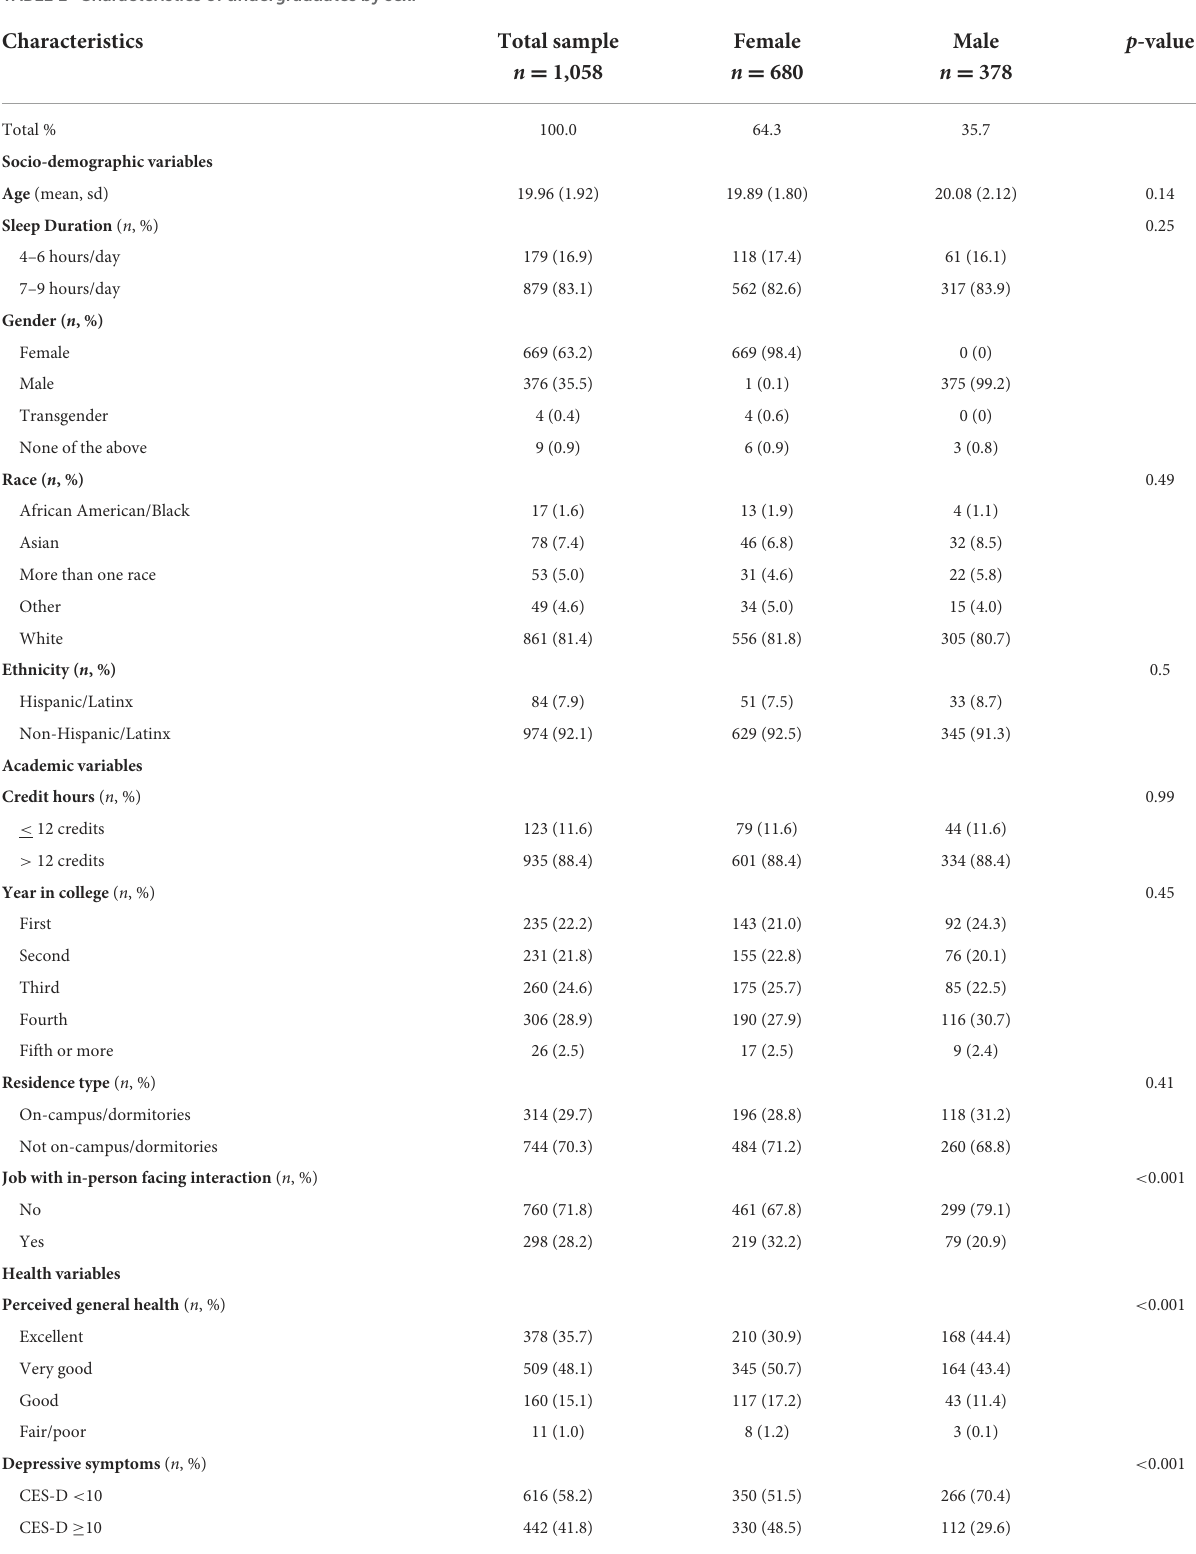
TABLE 1 Characteristics of undergraduates by